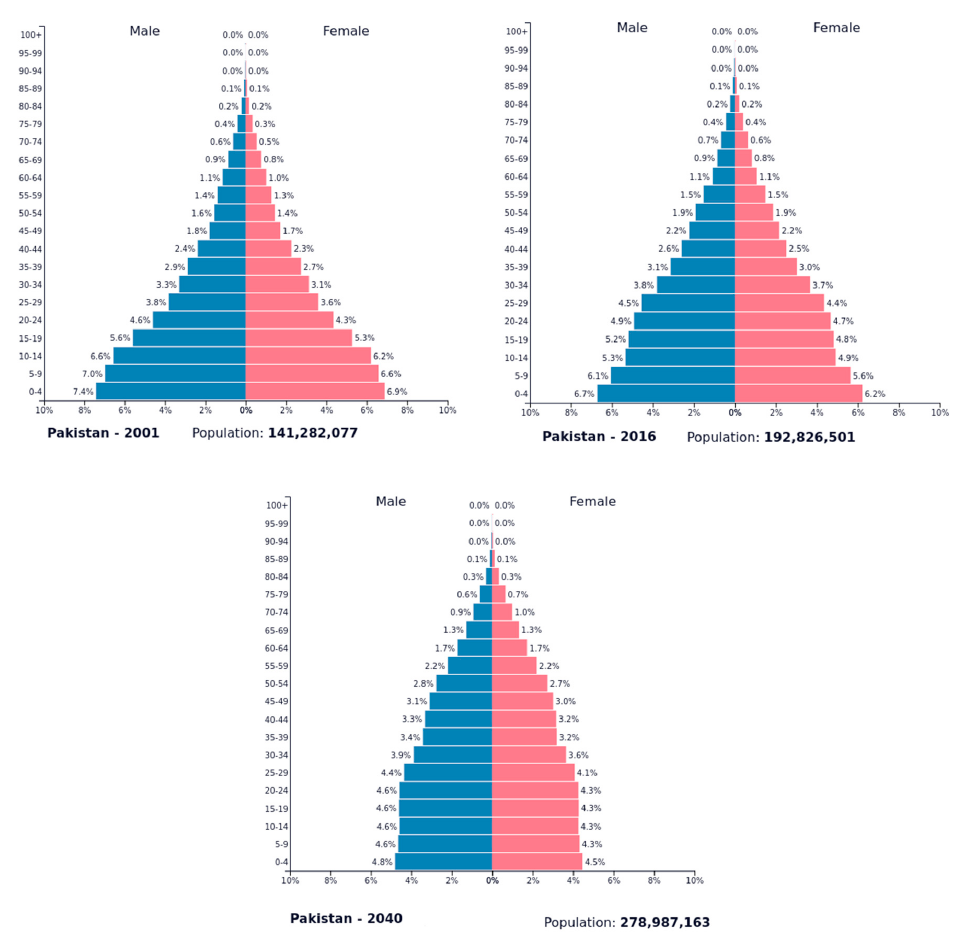
Figure 1. Population Pyramid. Source: United Nations Population Division, Department of Economic and Social Affairs. World Population Prospects: The 2015 Revision (Medium variant).